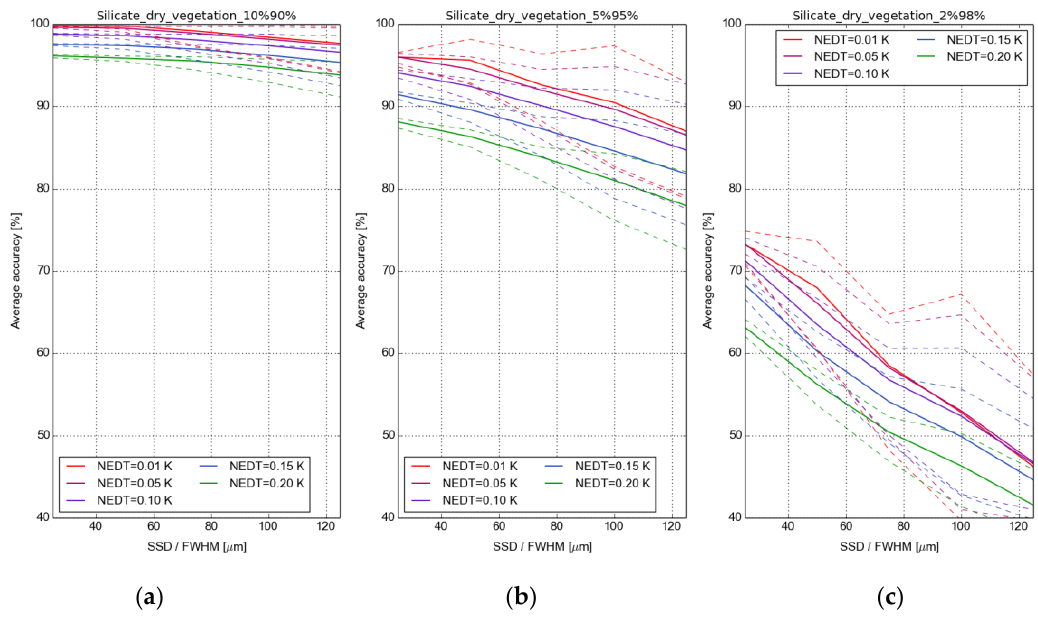
Figure 5. Accuracy assessment for the classification of silicates considering three mixture ratios and five noise levels: 10% mineral vs. 90% dry vegetation ( a ); 5% mineral vs. 95% dry vegetation ( b ); and 2% minerals vs. 98% dry vegetation ( c ). In the simulations it was assumed that the SSD equals the FWHM.